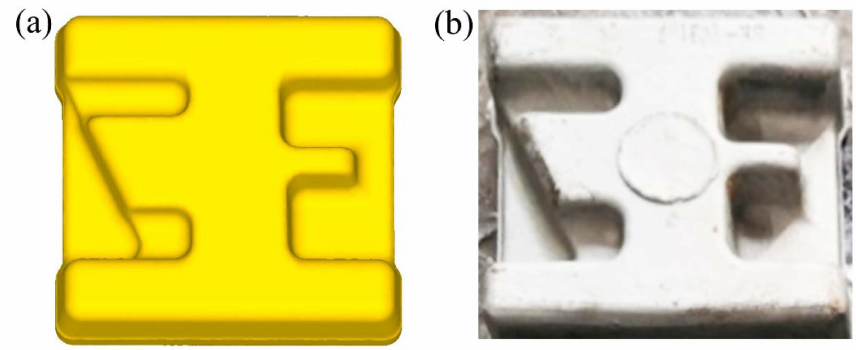
Figure 11. Comparison of components: ( a ) simulated component and ( b ) trial-produced component.